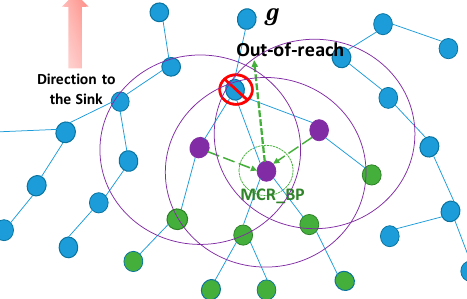
Figure 7. Avoid the same branch concept in NE-MCR algorithm.